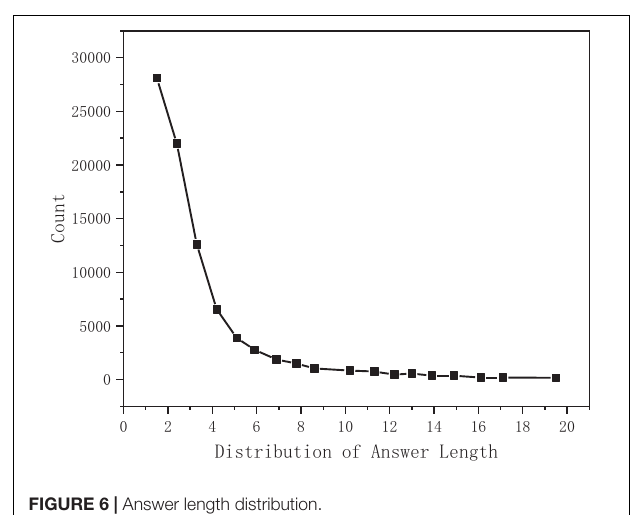
FIGURE 6 | Answer length distribution.